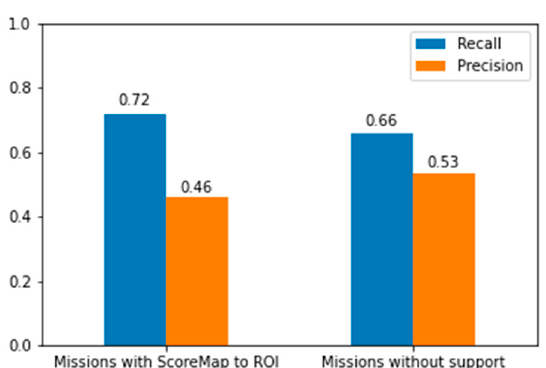
Figure 15. Comparing missions with the ScoreMap to ROI support and missions without support in recall and precision.